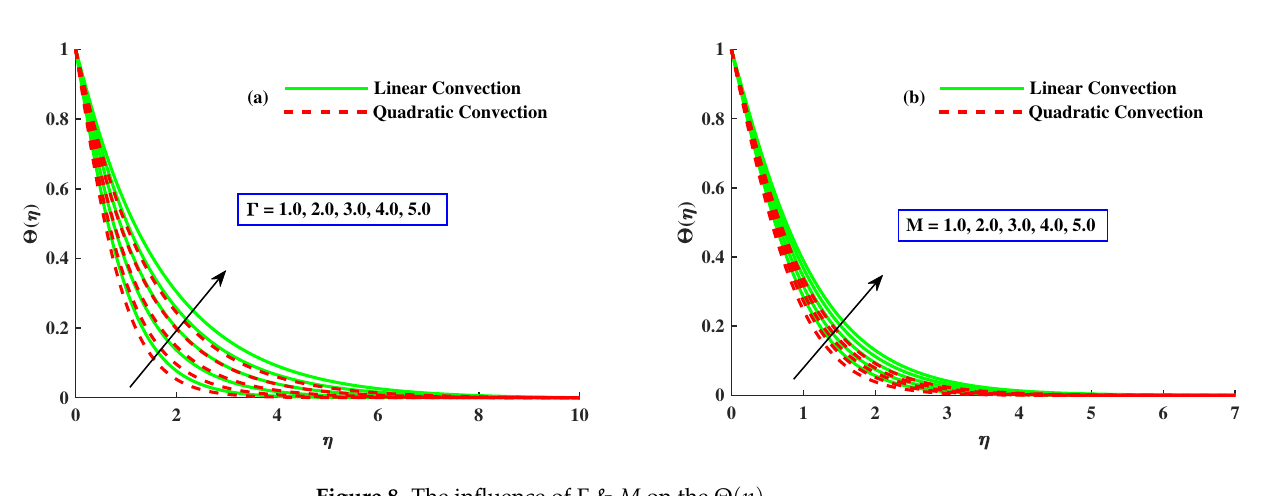
Figure 8. The influence of Γ & M on the Θ ( η ) . Figure 9a,b are drawn to show the variation in C f x ( Re ) 0.5 and C f y ( Re ) 0.5 when mag- netic and quadratic parameters are given distinct values with linear and nonlinear con- vection. The coefficient of skin friction ( C f x ( Re ) 0.5 ) decreased when M , K enhanced and also in the case of linear convection, but it has amplifying behavior along with quadratic convection, and the coefficient of skin friction ( C f y ( Re ) 0.5 ) undergoes a notable increment by higher values of M along linear convection, but it shows a significant decrement by greater inputs of K with quadratic convection. Figure 10a,b indicates the fluctuation in C f x ( Re ) 0.5 and C f y ( Re ) 0.5 with varying values of material and mixed convection parameter along quadratic and without nonlinear convection. Figure 10a represents the increment in C f x ( Re ) 0.5 with growing inputs of λ and, in the case of nonlinear convection. However, it recedes with incremental values of Γ and in the absence of nonlinear convection. Figure 10b displays that C f y ( Re ) 0.5 increased with larger values of the material parameter with linear convection and decreased by varying values of λ 1 with quadratic convection. Figure 11a,b discloses that Nusselt number ( Nu ( Re ) 0.5 ) is lessened with elevated inputs of M and Γ in both cases but boosted with increasing values of λ 1 and K with quadratic convection.